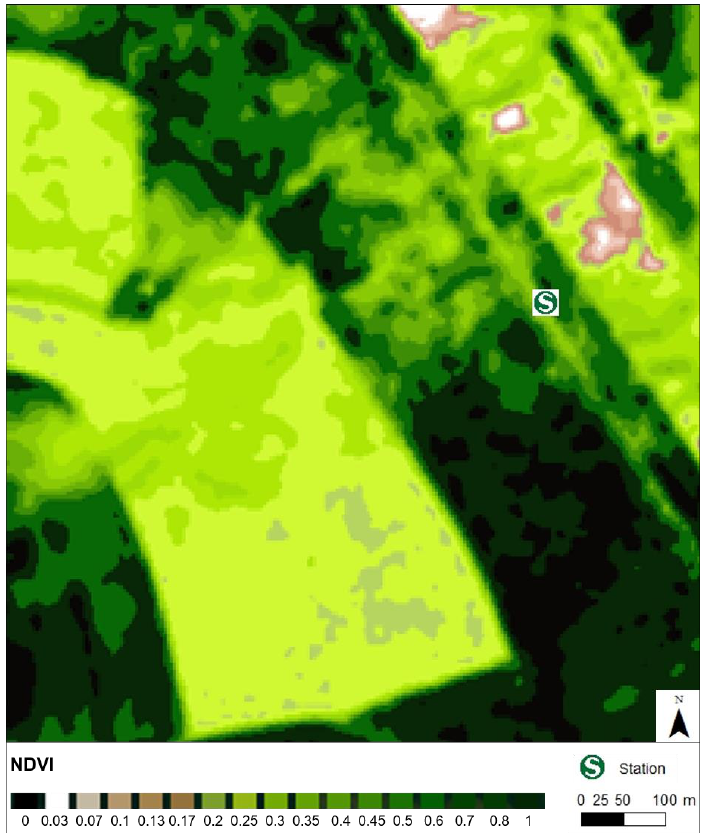
Figure 3. The NDVI of the study area [52].